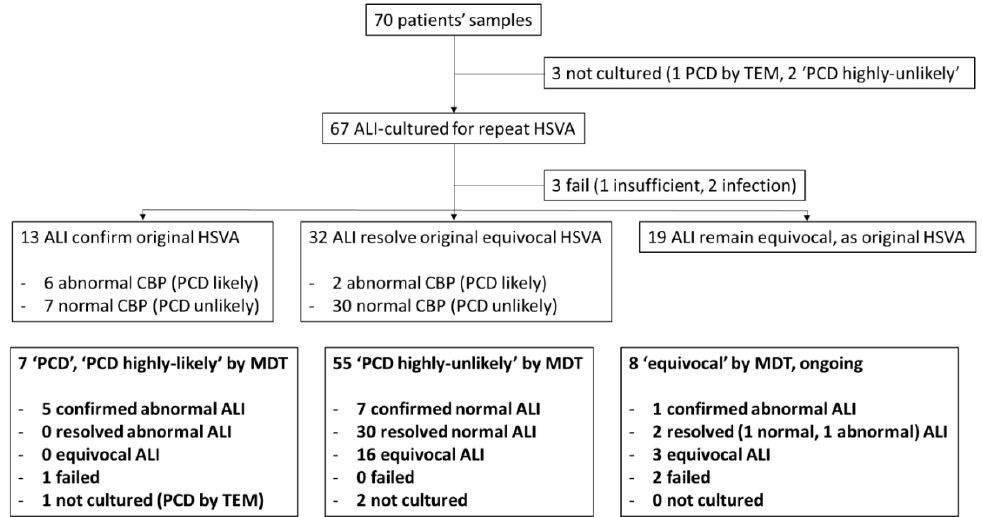
Figure 2. Flow diagram of diagnostic sample processing for ALI culture by repeat HSVA and MDT outcomes. Seventy patients’ ex vivo samples evaluated by HSVA (as part of the whole diagnostic process) and their ALI culture outcomes were followed. HSVA on ALI culture either confirmed the original HSVA finding, resolved an originally equivocal HSVA or remained equivocal despite culture. In bold, the ALI culture HSVA outcomes are shown by MDT outcome (“PCD”/“PCD highly-likely”; “PCD highly-unlikely” or “equivocal” pending follow up, repeat tests or further tests (genetics or additional IF for example).